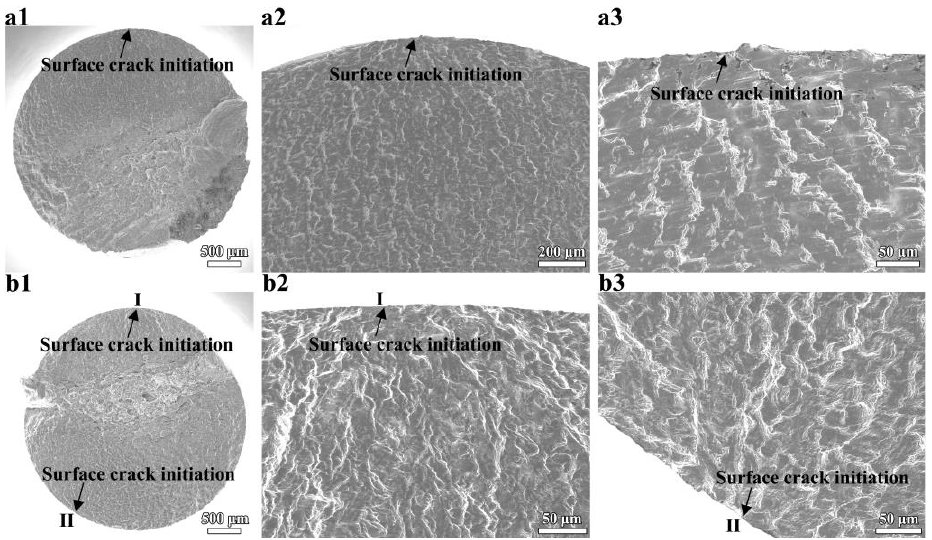
Figure 11. Fatigue fracture surfaces of 25CrMo4 specimens under discontinuous cyclic loading: ( a1 – a3 ) Specimen failed from single-site crack initiation: 𝜎 𝑎 = 330 MPa, N f = 1.6 × 10 6 cycles; ( a2 , a3 ) are enlarged views of the crack initiation site. ( b1 – b3 ) specimen failed from multi-site crack initiation: 𝜎 𝑎 = 330 MPa, N f = 6.4 × 10 5 cycles; ( b2 , b3 ) are enlarged views of the two crack initiation sites.